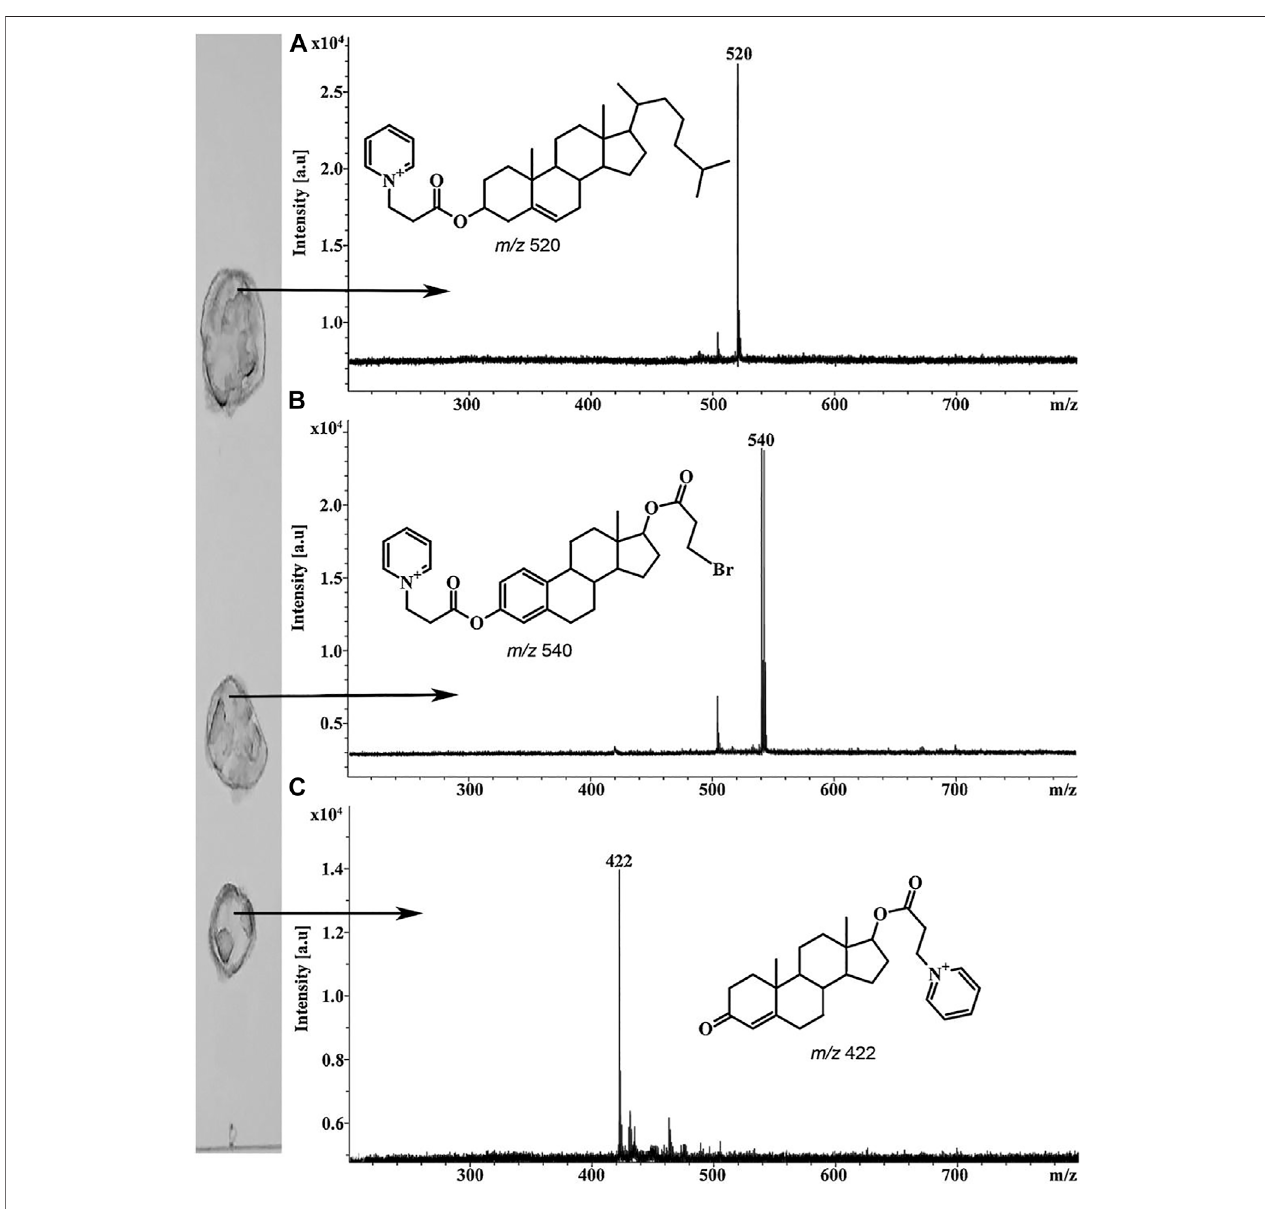
FIGURE 4 | MALDI mass spectra of steroid alcohols derivatized on the TLC plate cholesterol (A) , β -estradiol (B) , positions of bromopropionyl and pyridiniumpropionyl groups may vary and testosterone (C) . Figure reprinted with permission from Esparza et al. (2018). Copyright (2018) Elsevier B. V.